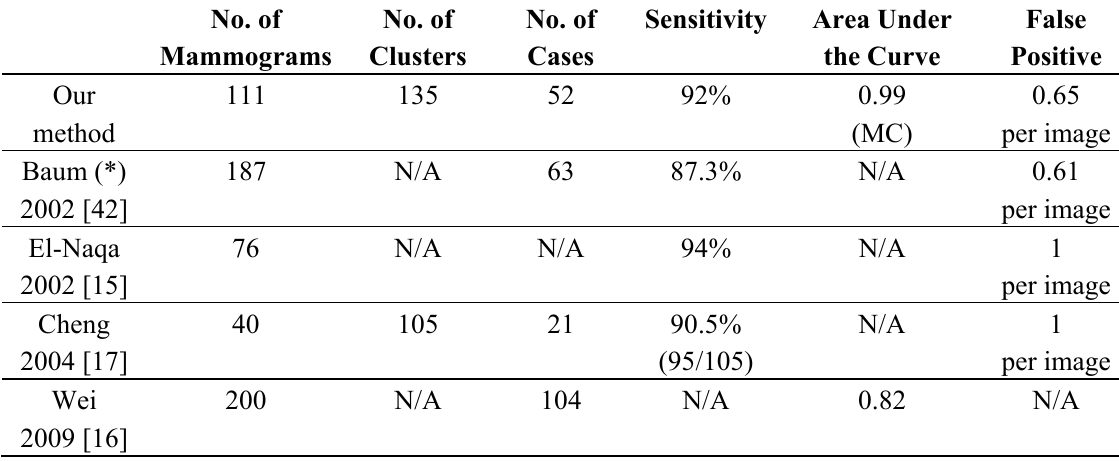
Table 4. Comparison between different